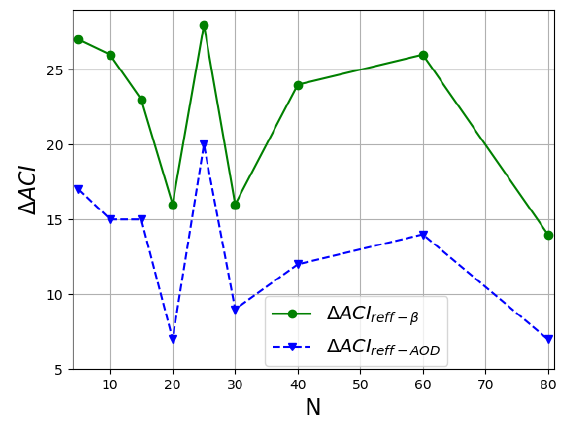
Figure 6. ∆ ACI ref f − β and ∆ ACI ref f − AOD with respect to the number of simulations ( N